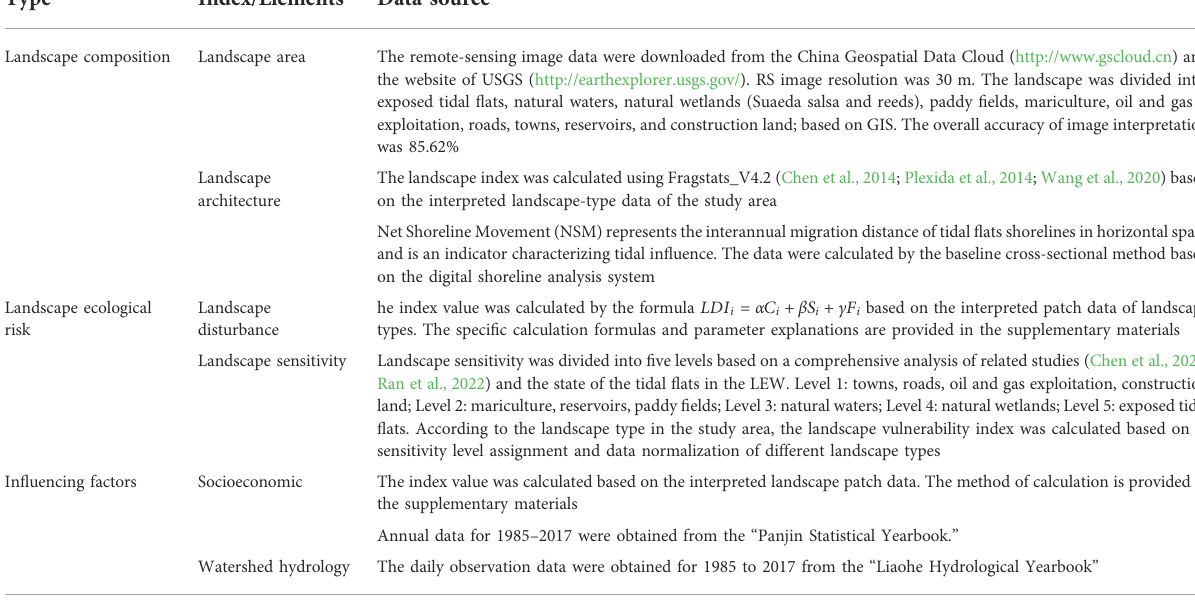
TABLE 1 Research indicators and data sources.